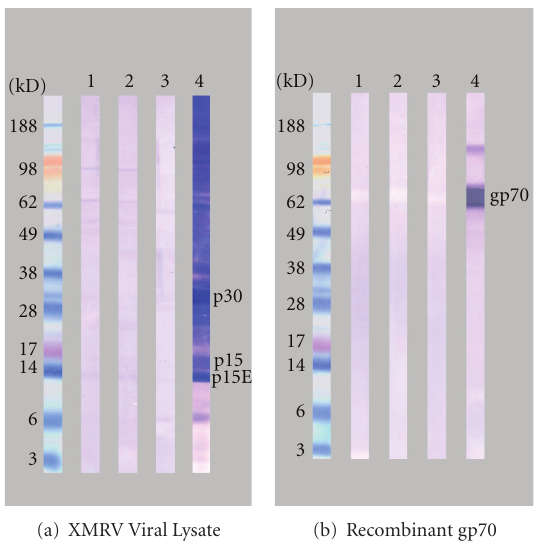
Figure 2: WB analysis of gp70 CMIA reactive samples with (a) native XMRV viral proteins and (b) recombinant gp70. WB strip key: 1 & 2: gp70 reactive samples 137 and 138; 3: normal blood donor plasma as negative control; 4: XMRV-infected macaque plasma as positive control. The faint white band in the 65–70 kd region in (B, strips no. 1–3) indicates a lack of specific anti-gp70